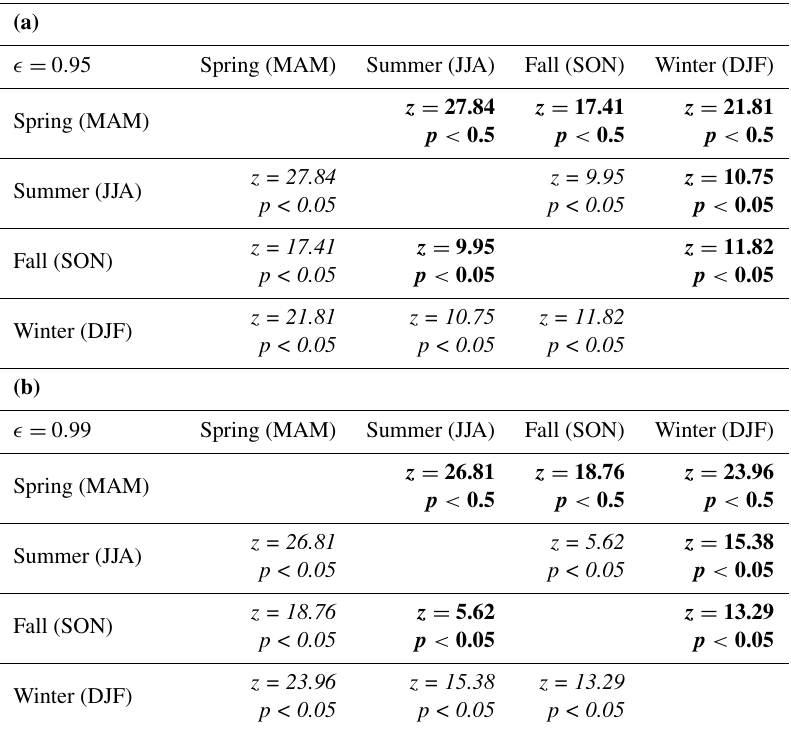
Table 5. Results for Wilcoxon rank sum tests between modeled temperature inversions by season. Inversions ( T surface − T air ) were calculated from ERA5 and Divide AWS data. Bolded cells indicate a larger inversion in the column season; italicized cells indicate a larger inversion in the row season; and standard-font cells indicate no significant difference between the